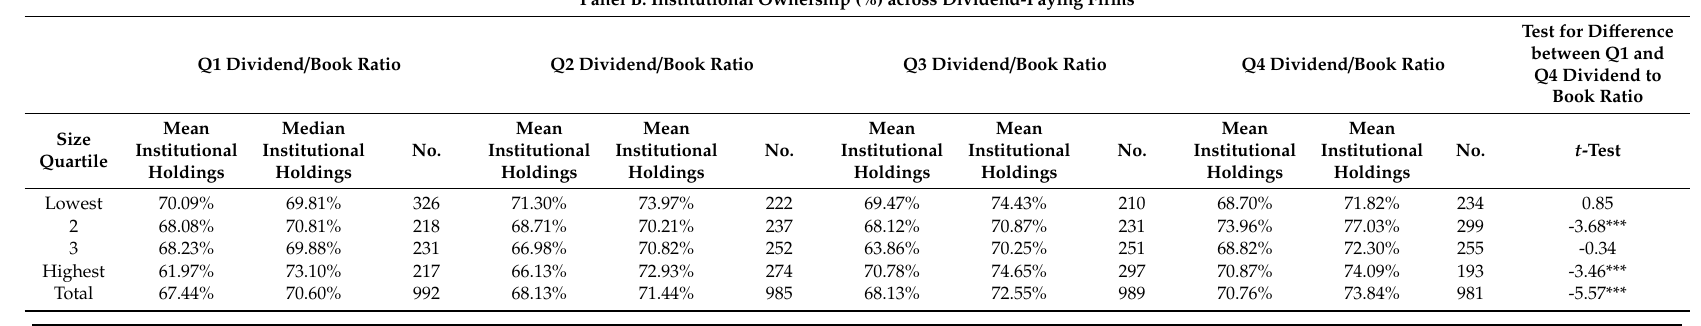
Panel B: Institutional Ownership (%) across Dividend-Paying Firms